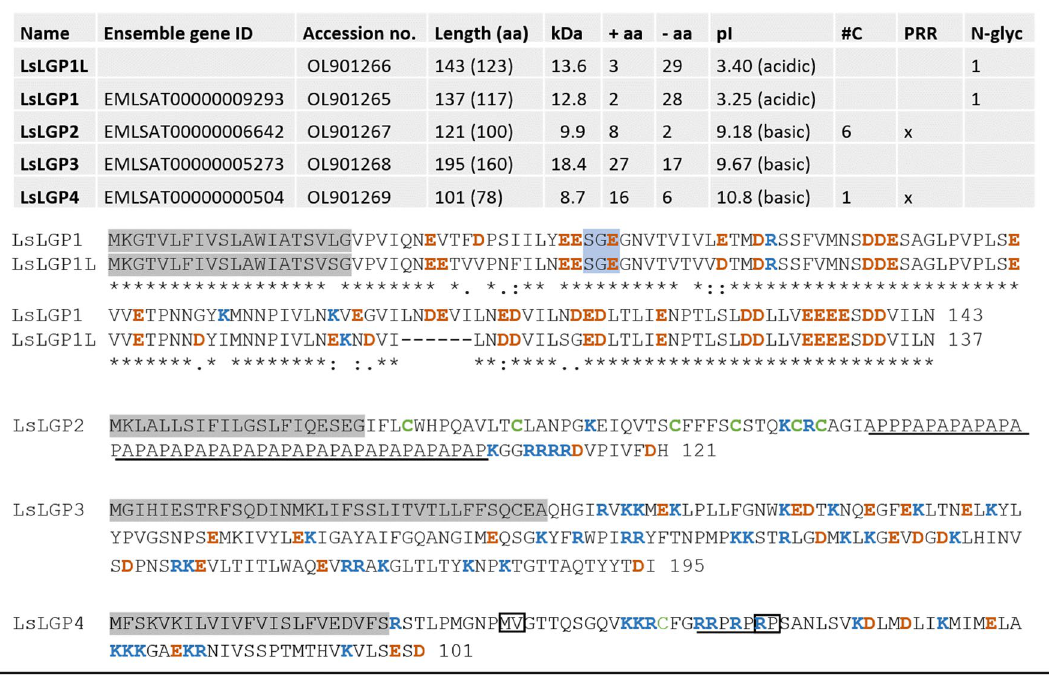
Figure 2. Overview of the predicted L. salmonis labial gland protein (LsLGP) 1–4. Upper panel (table): Both the length of the complete ORF and the length of mature sequences (in parentheses) is given, while the putative mass in kDa is given for the mature proteins only. Aa amino acids, pI theoretical isoelectric point, #C number of cysteines, PRR proline rich region. Lower panel: Predicted leader sequences are indicated with a grey background, while predicted N-linked glycosylation site are indicated with a blue background. Positively and negatively charged amino acids are shown in blue and red, respectively, while cysteines are depicted in green. PRR’s are underlined, while the two amino acid deletions identified in LsLGP4 is marked with squares. LsLGP1 and 1L are aligned to show identical (*) and similar (: or.) amino